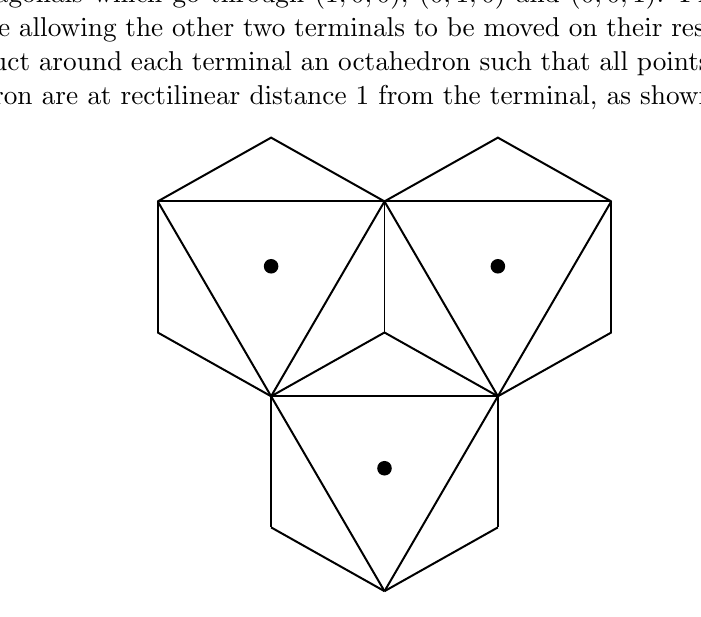
Figure 4: Octahedrons. Diagonals, as projected onto a plane perpendicular to the vector (1 , 1 , 1) , are indicated by means of